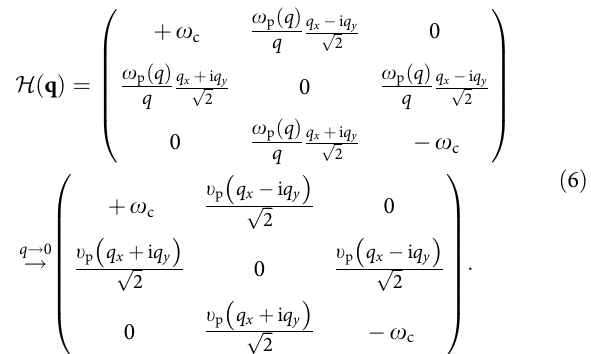
q ffiffiffiffiffiffiffiffiffiffiffiffi o 2 q ð Þ p ffiffiffiffiffiffiffiffiffiffiffiffiffiffi q þ q 2 q 2 x y